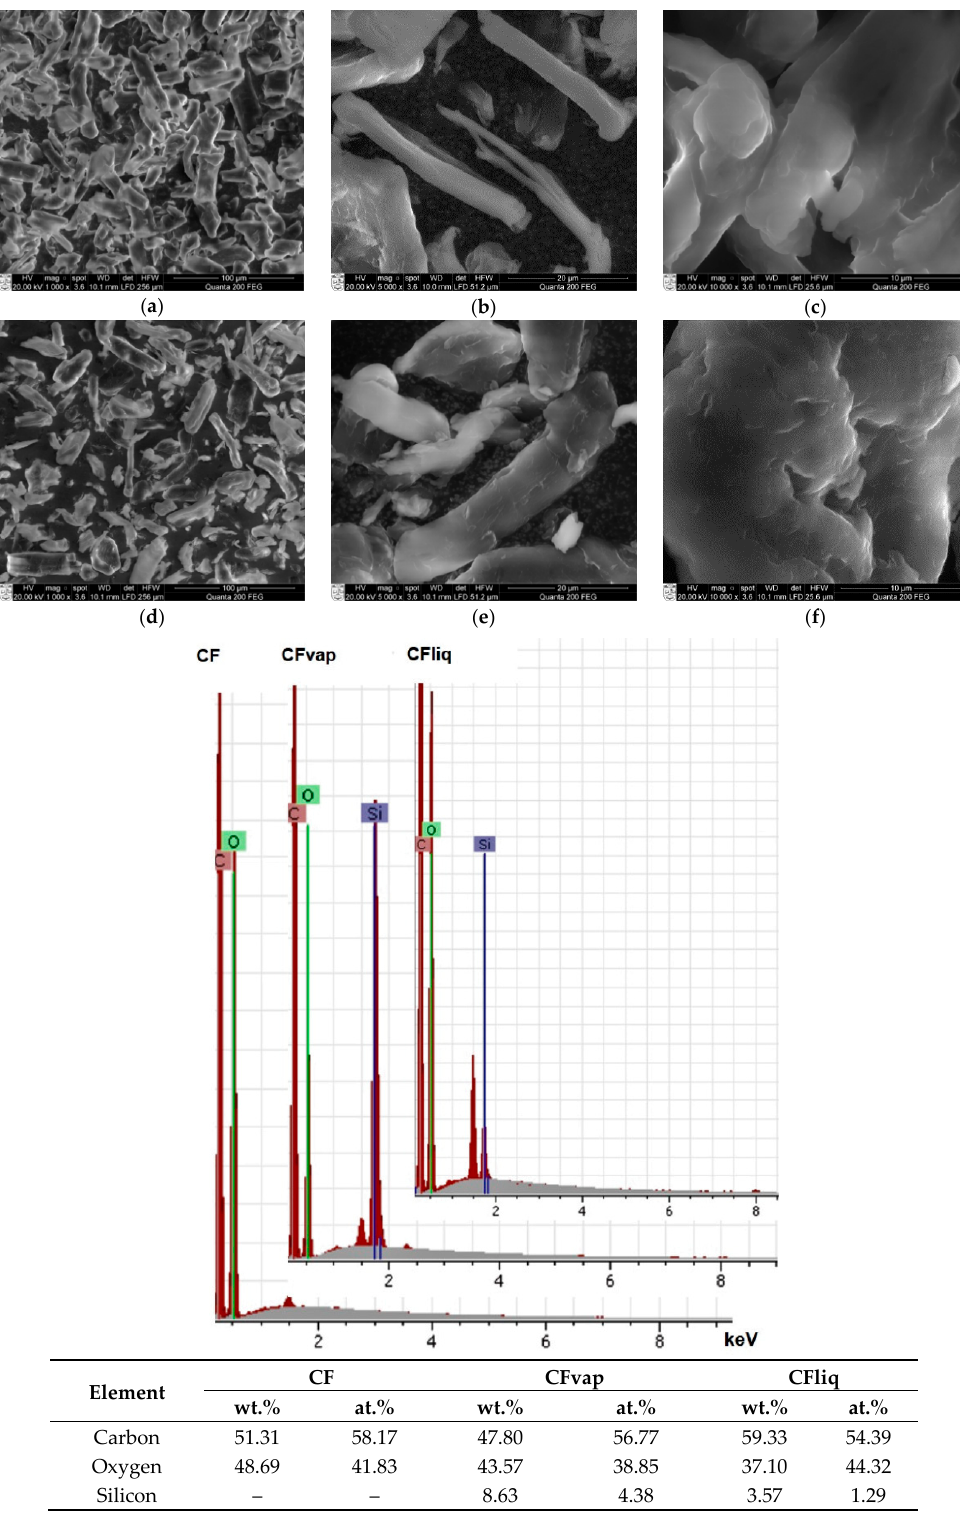
Figure 5. SEM images at different magnifications of ( a – c ) CFvap and ( d – f ) CFliq. ( g ) SEM-EDS data of all cellulose samples.